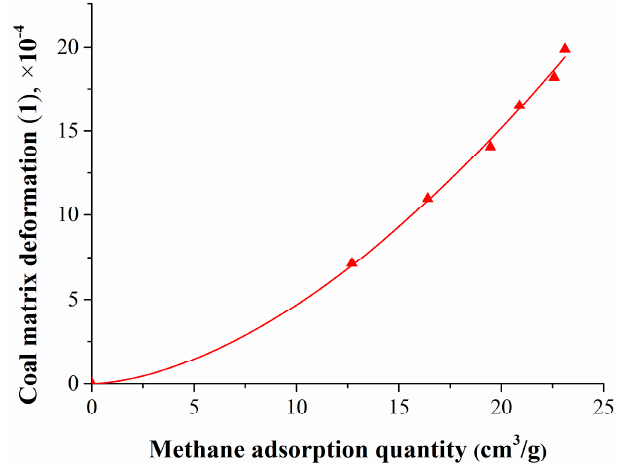
Figure 5. Relationship between coal matrix deformation and the methane adsorption quantity.